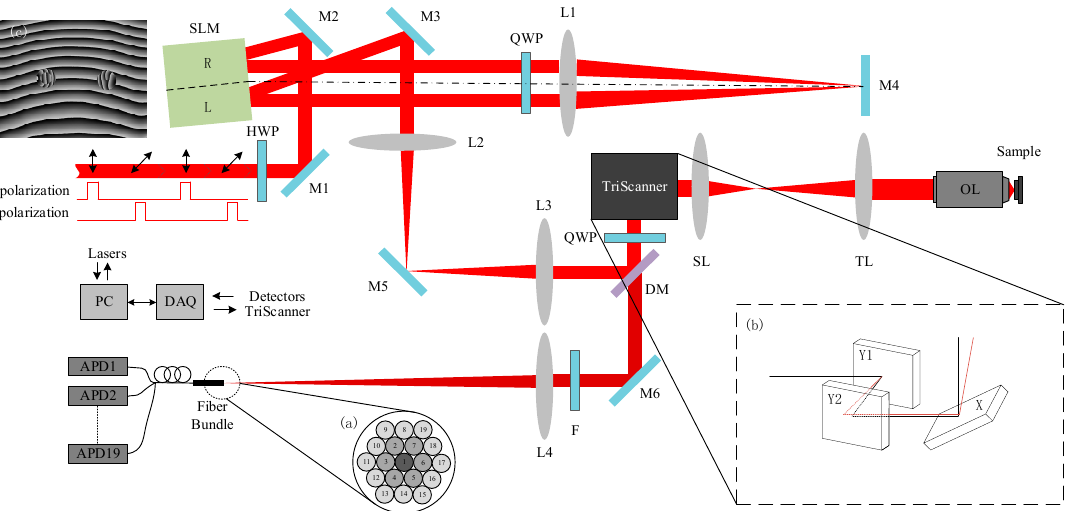
Figure 4. Schematic of 3D-PRFED setup. HWP: half wave plate; SLM: spatial light modulator; QWP: quarter wave plate; DM: dichromatic mirror; TriScanner: scanner module using 3 galvanometers; SL: scanning lens; TL: tube lens; OL: objective lens; M1 ~ M6: mirror; F: fluorescence filter; L: lens; PC: personal computer; DAQ: data acquisition card; APD: avalanche diode detector. inset: ( a ) the fiber bundle cross-section used as the detector array; ( b ) the triscanner sketch; ( c ) the modulated pattern on the SLM.